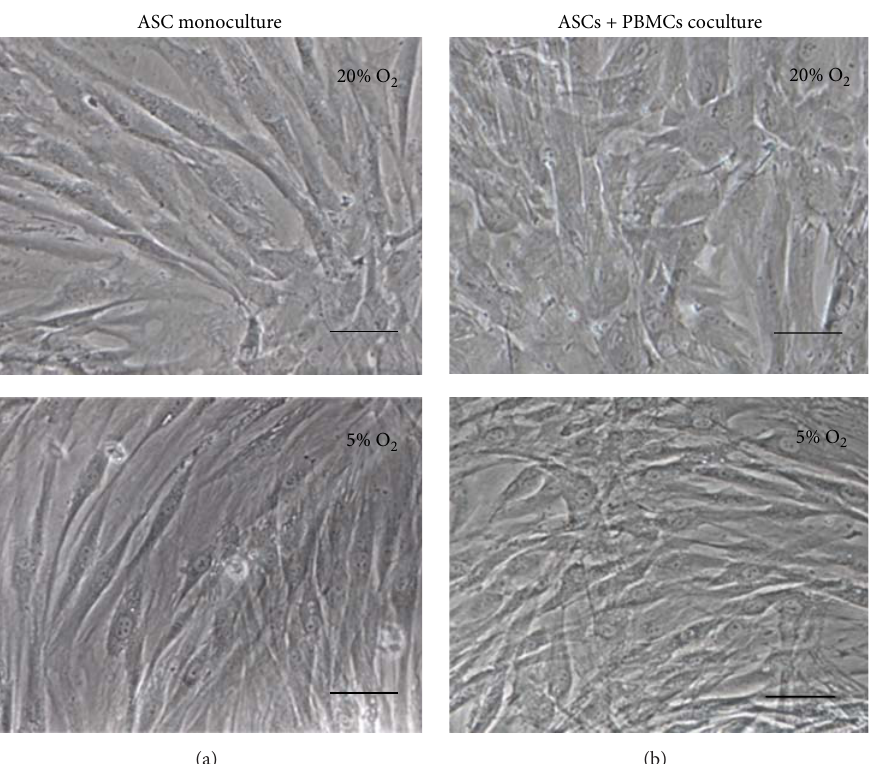
Figure 1: ASC morphology in monoculture and after transwell coculture with PHA-stimulated PBMCs under 20% and 5% O 2 . Phase contrast: bar 100 𝜇